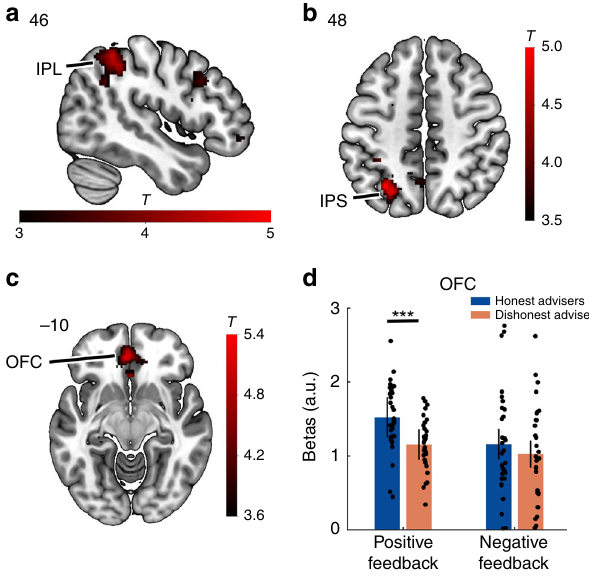
Fig. 6 Modulation of neural responses to value information. Whole-brain contrast analyses from GLM3 on the feedback phase yielded signi fi cant activations in the parietal cortex for dishonesty during both positive ( a ) and negative outcomes ( b ). Honesty, on the contrary, modulated only positive outcomes in the OFC ( c ). An ROI analysis ( d ) indicated higher activity in the OFC in response to positive outcomes when interacting with honest advisers ( t test). Error bars indicate standard errors across participants. Each dot represents one participant. See also Supplementary Tables 3 –